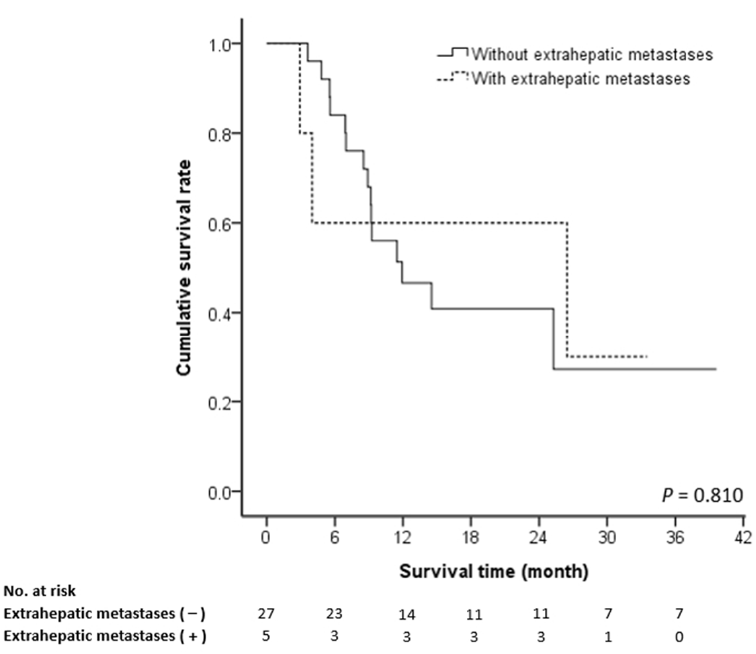
Figure 4. Cumulative survival rate according to the presence of extrahepatic metastasis. Table 3. Prognostic factors for survival in HAIC followed by lipiodol infusion.